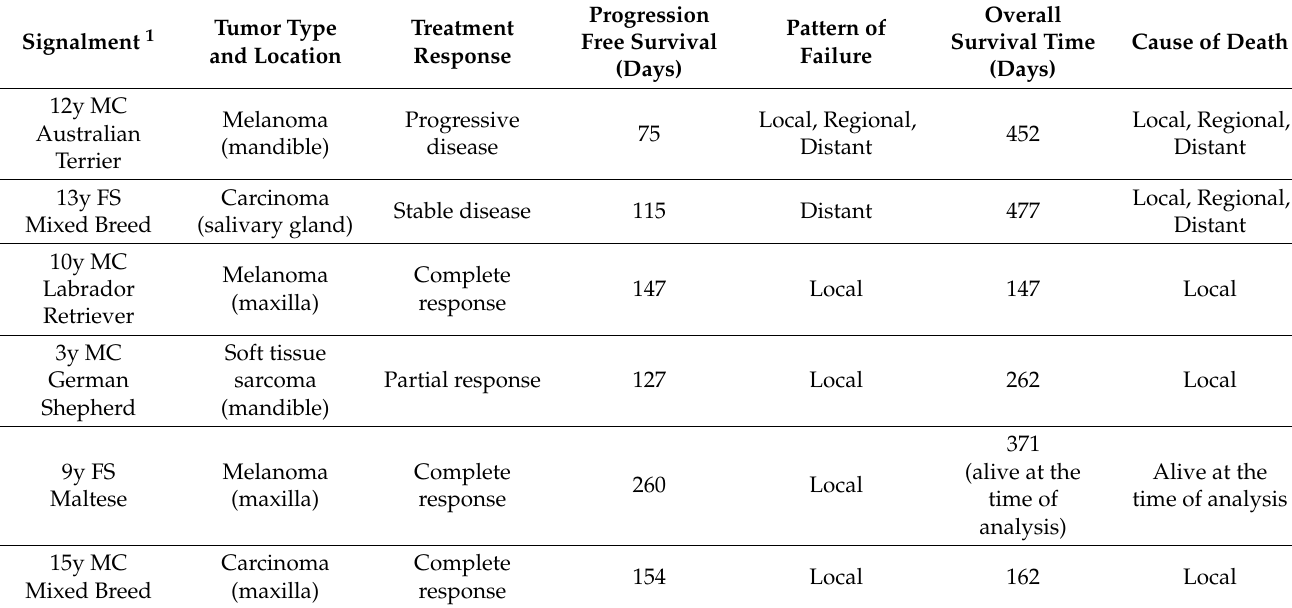
Table 2. Treatment response and survival data for study